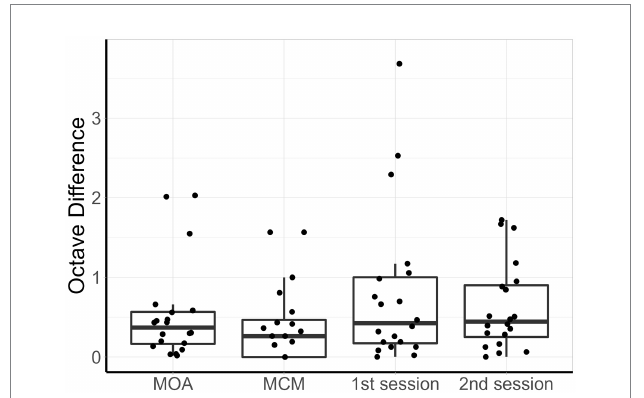
FIGURE 5 Box plots of the difference in octaves, from left to right: MOA within- method, MCM within-method, 1st session between methods, 2nd session between methods. For each boxplot, the data points represent individual